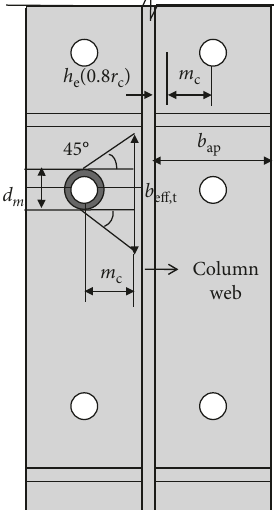
Figure 15: Calculation sketch of the effective tensile width of the column web. Table 10: Value of effective tensile width.